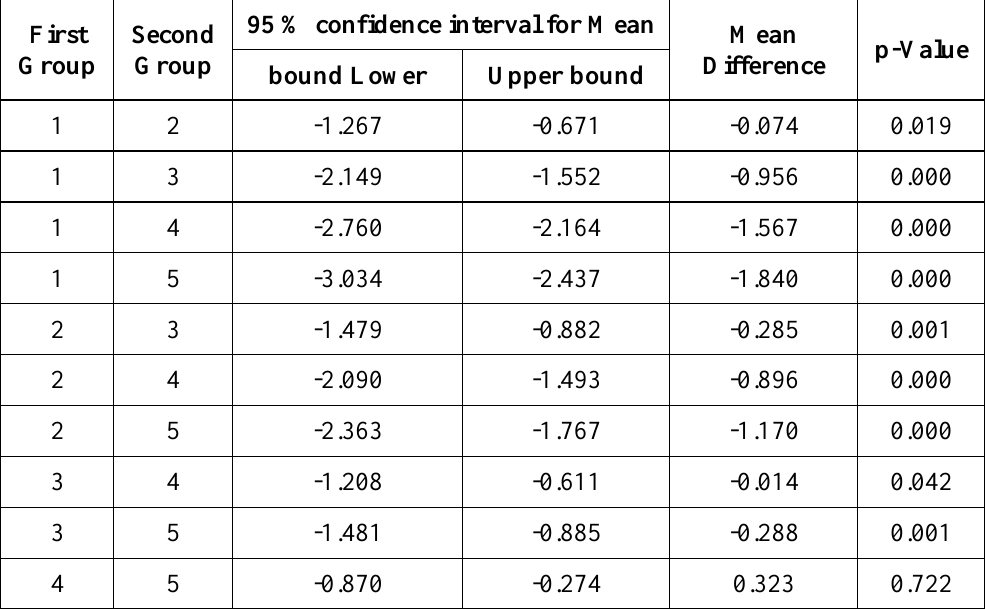
Table 11. One-Way Analysis of Variance of Value at Risk in Pairwise